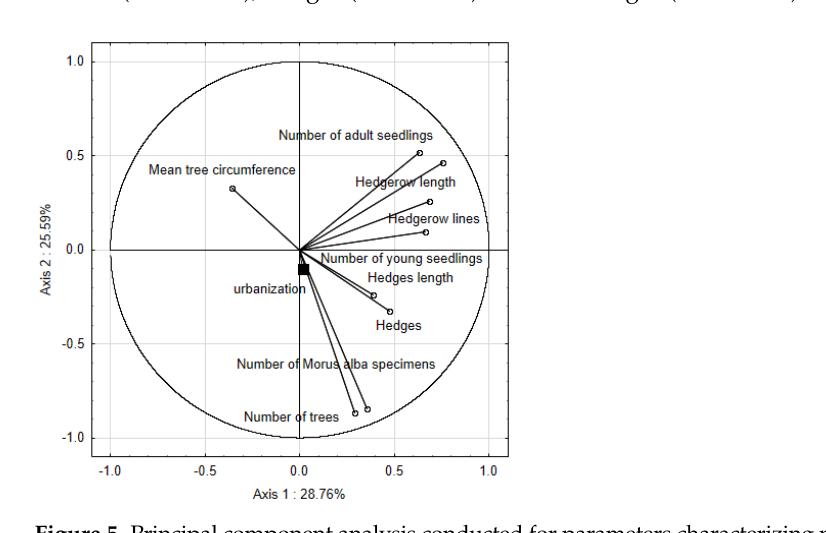
Our calculations revealed a significant difference in the number of trees within dif- ferent thermal categories defined for Wroc ł aw. The highest quantity of Morus alba (H = 9.457; p = 0.024) and trees (H = 11.486; p = 0.009) was detected for thermal factor between 4.1 and 6.9 °C, whereas the lowest –in areas where the temperature is below 4 °C (Figure